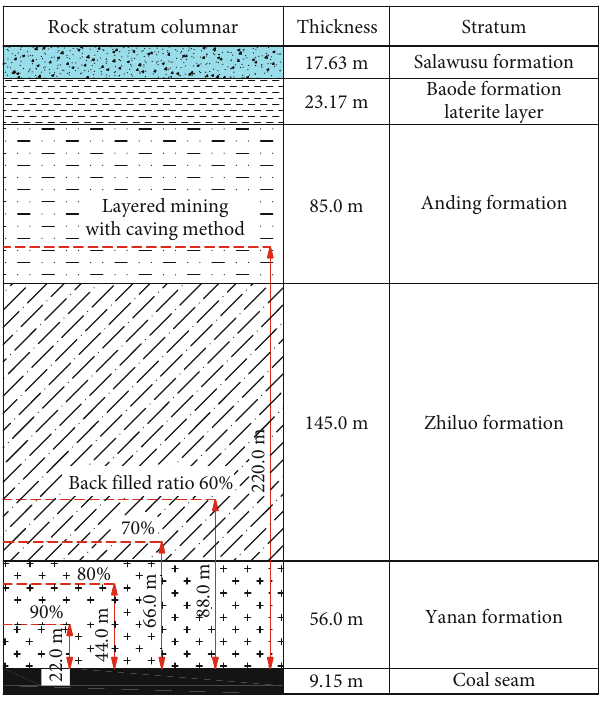
Figure 4: Analogy results of the height of the water-conducting fractured zone under di ff erent mining